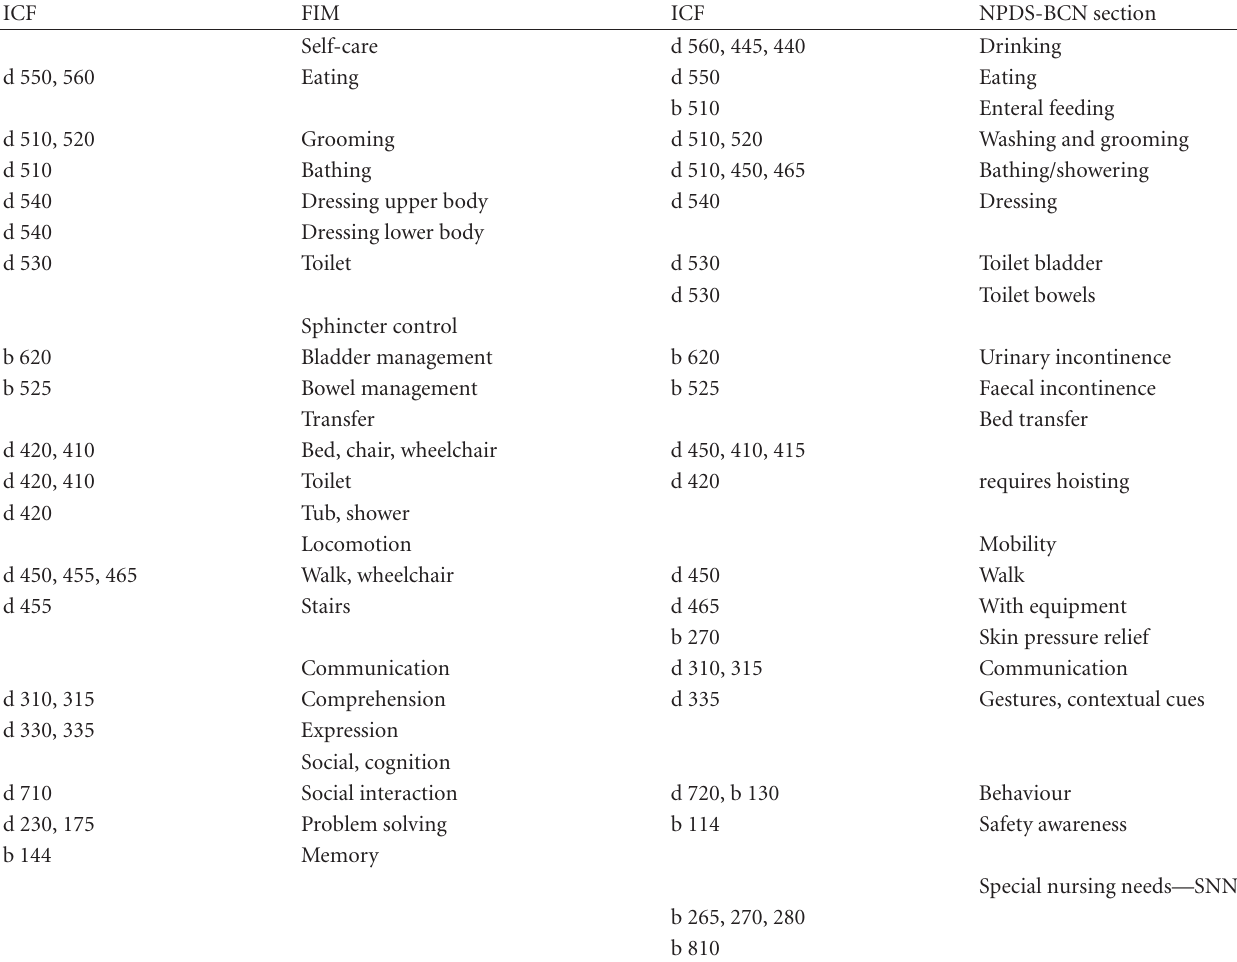
Table 5: Comparing FIM and NPDS to the International Classification of Functioning, Disability, and